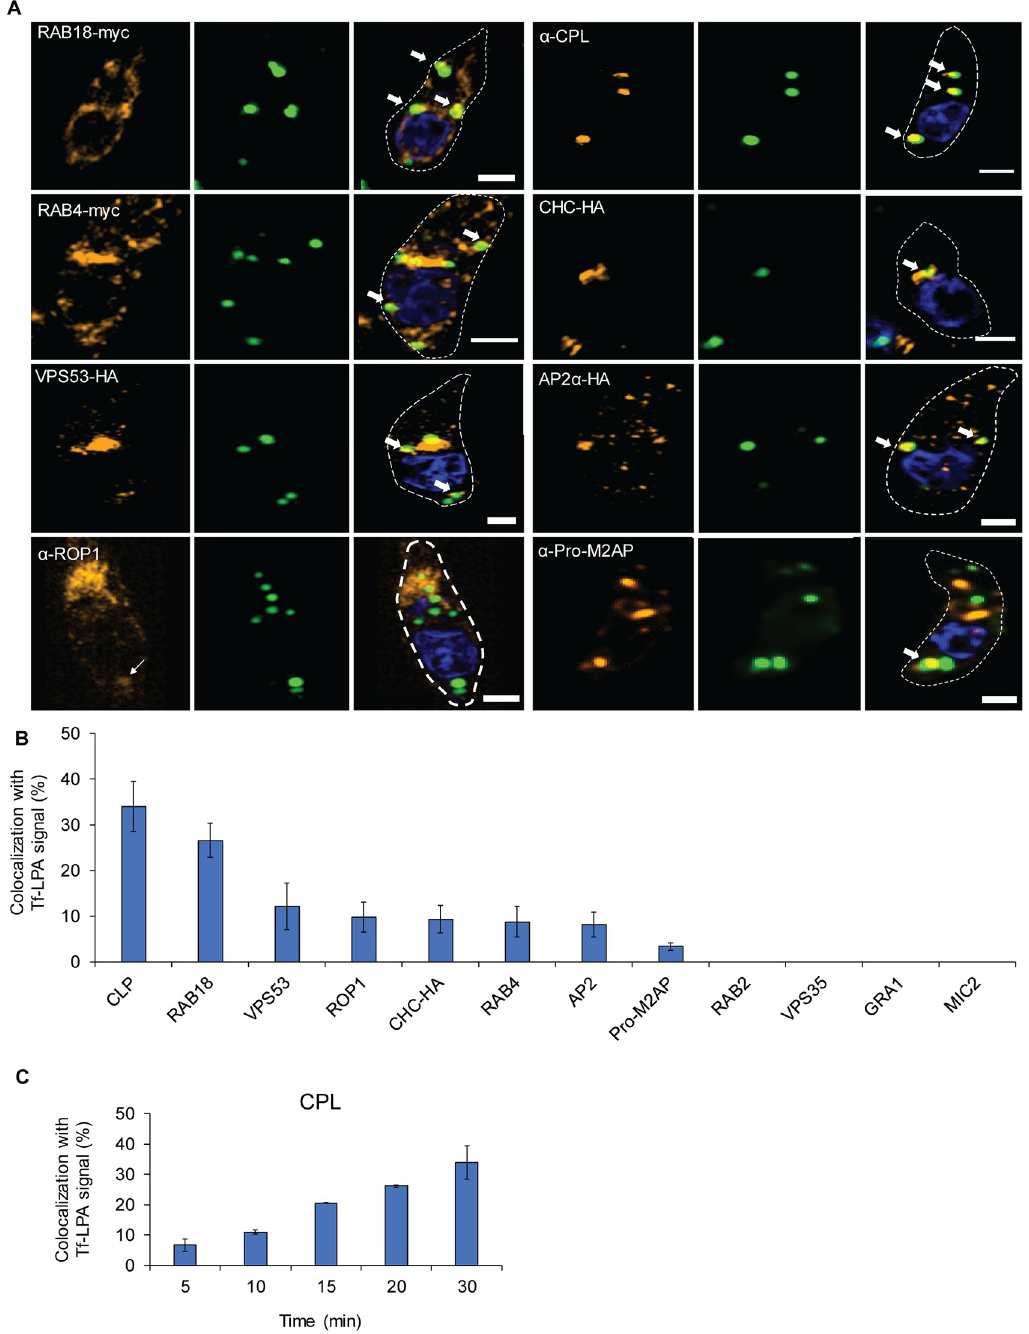
Fig 3. Endocytosed lipids traverse the secretory system. (A-B) Tf-LPA vesicle localisation was determined using indicated parasite strains expressing markers for the parasite trafficking system: dd-RAB18-myc: ER, dd-RAB4-myc: Golgi, VPS53-HA: TGN, VPS35-HA: Retromer/ELC, CHC-HA: Golgi, TGN, AP2 α -HA parasites [31,32,43,44]. Antibodies against the VAC ( α - CPL [37]), rhoptries ( α -ROP1), micronemes ( α -MIC2), and dense granules ( α -GRA1) were used after fixation on RH parasites. (A) Representative pictures of colocalisations are shown (see also S4 Fig); scale bar, 1 μ m. (B) Quantification of colocalisations. Mean values of three independent assays are shown ± SD. (C) Accumulation of Tf-LPA in the VAC over time. Percentage of colocalisation between Tf-LPA and CPL was determined from 0 to 30 minutes after Tf-LPA addition. Mean values of three independent assays are shown ± SD. For each bar graph, the corresponding data can be found in S1 Data. CHC, clathrin heavy chain; CPL, cathepsin L; dd, destabilisation domain; ELC, endosome-like compartment; ER, endoplasmic reticulum; Tf-LPA, Top-Fluor lysophosphatidic acid; TGN, Trans -Golgi network; VAC, vacuolar-like compartment; VPS, vacuolar protein sorting- associated protein.